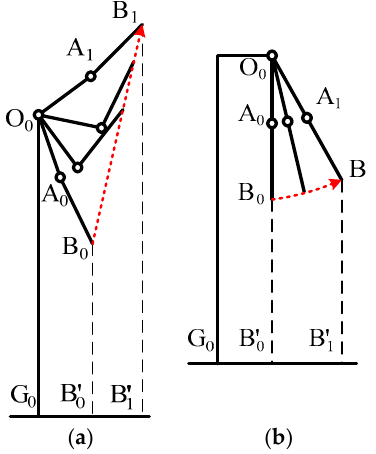
Figure 9. End ‐ effector trajectory: ( a ) Raising ‐ up; and ( b ) Lateral ‐ lifting. Figure 9. End-effector trajectory: ( a ) Raising-up; and ( b ) Lateral-lifting. Table 8. Parameters of the end ‐ effector trajectory. Table 8. Parameters of the end-effector